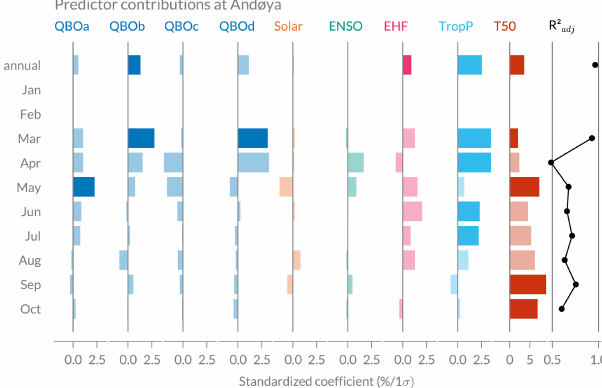
Figure B1. Predictor contribution to the regression fit at Andøya for the annual regression fit and individual monthly fits. The last panel on the right shows the adjusted coefficient of determination ( R 2 ) for the annual and all monthly fits. Note that the range of the adj x axis is different for T50 than for the other predictors.